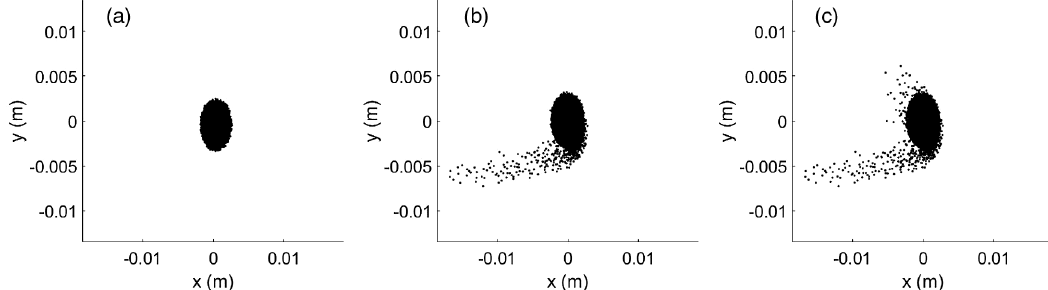
FIG. 21. Simulated beam halo profiles at screen monitor SCM8 location. The steering coils are on. The horizontal offset of the cavity No. 2 is 2.6 mm, and the common vertical offset of 2 mm is assumed for the cavities Nos. 1 – 3. The collimators COL1 and COL2 are taken out. (a) Demonstration of those for the 3.3 ps Gaussian core. (b) For the 3.3 ps Gaussian core with 100 ps bunch back tail. (c) For the 3.3 ps Gaussian core with back and forward tails.